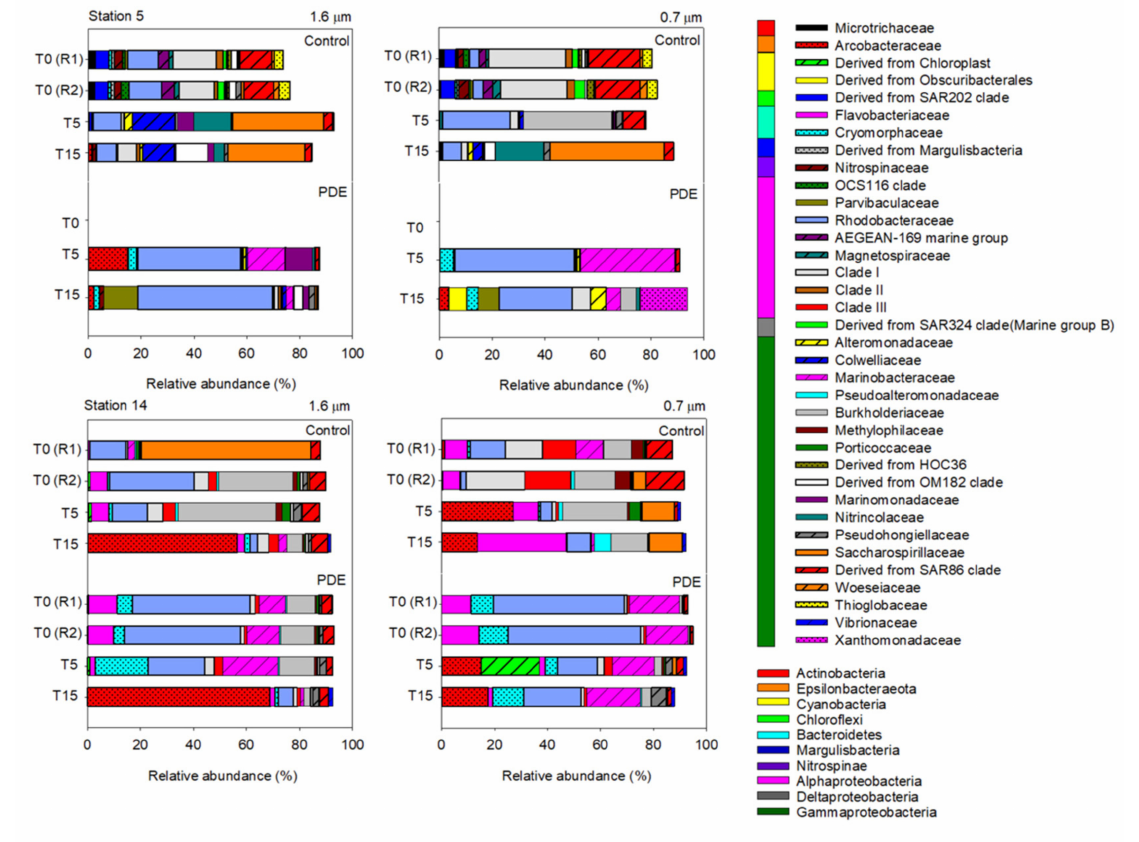
Figure 7. Contribution of active families through the incubation based on the SIMPER results. List of the OTUs explaining 50% of the dissimilarity observed during the experiment between treatments with PDE addition and control (without PDE) for each station. Upper panels correspond to marine station 5 and lower panels to estuarine station